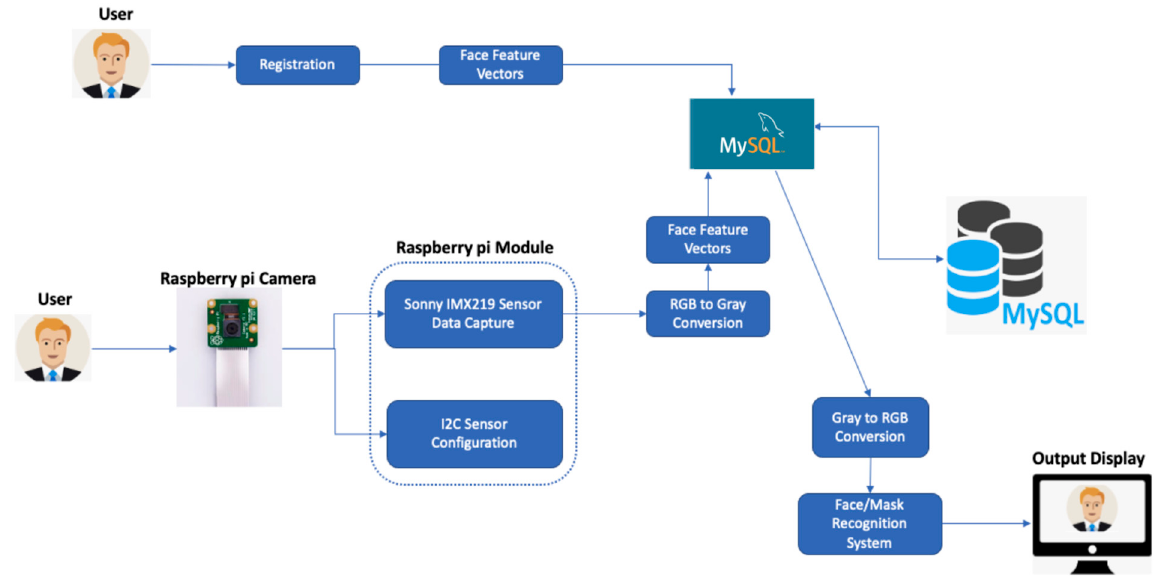
Figure 16. Employee Data Operation Flow.